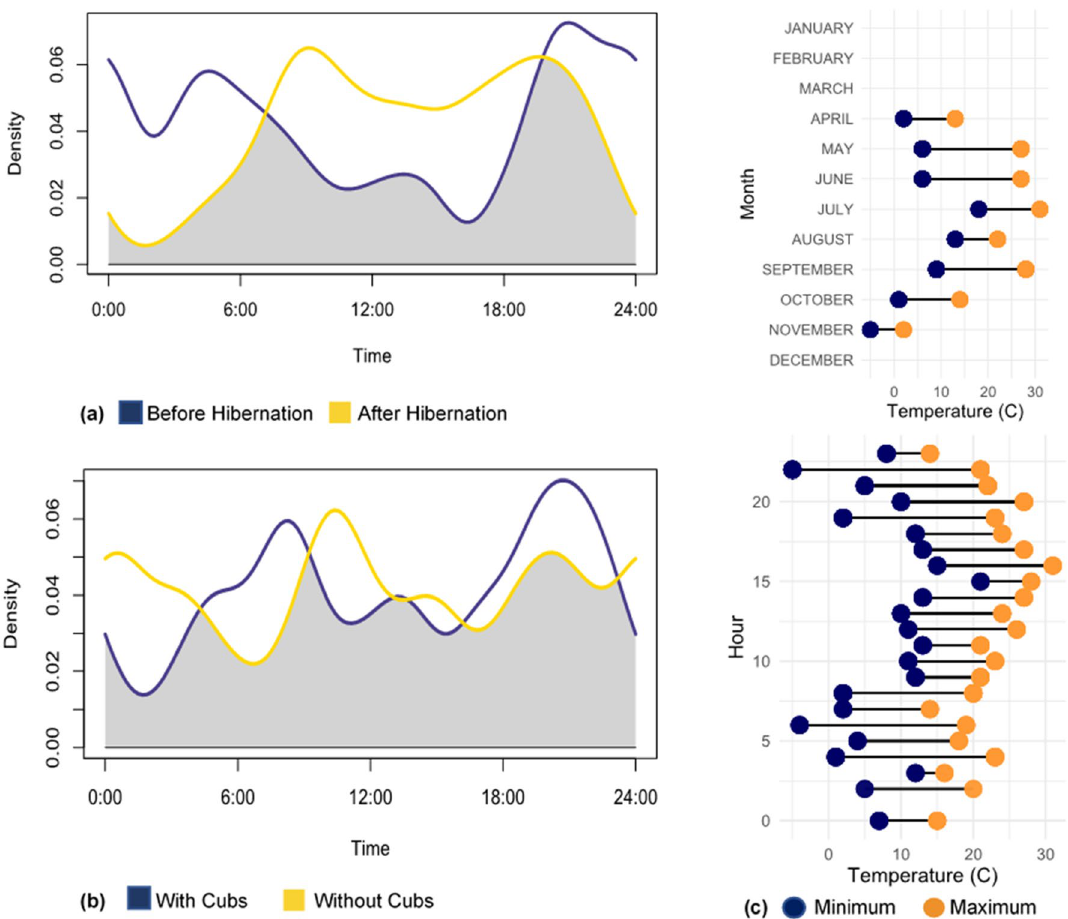
Figure 3. Temporal activity with relation to environmental temperature. ( a ) Black bear activity before and after hibernation. ( b ) Black bear activity with and without the presence of cubs. The gray area under the curves represents the overlap between the two activity patterns. ( c ) Minimum and maximum temperatures recorded for all black bear detections grouped by month and hour of the day.